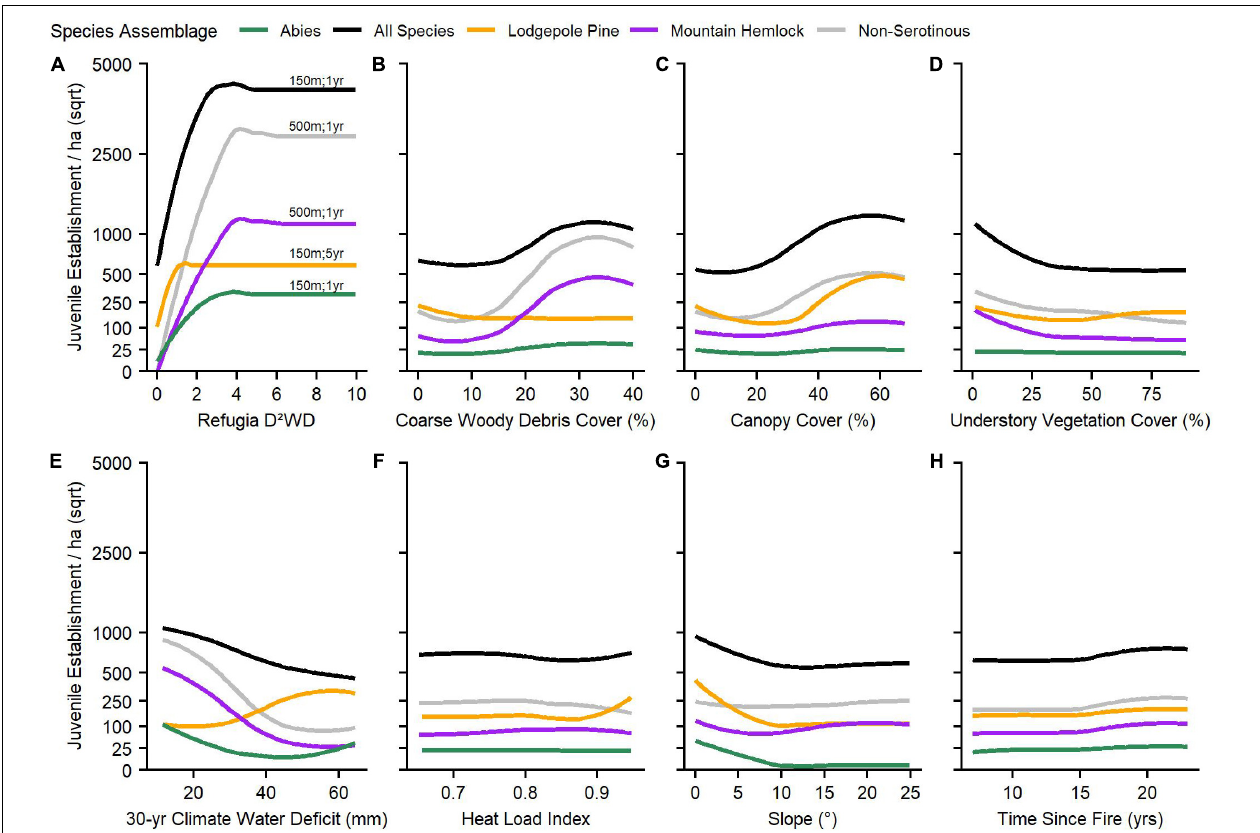
FIGURE 4 | Partial dependence plots illustrating the smoothed flexible relationship between post-fire conifer juvenile establishment responses and refugia, climate, and environmental variables, by species assemblage (A–H) . Each plot represents the fitted values of juvenile establishment response (y) due to the predictor variable (x), while keeping all other predictor variables fitted in models at their mean values. For the refugia D2WD variable, the best performing neighborhood radius and post-fire temporal snapshot associated with each species assemblage model is listed above each response curve (i.e., #m; #year). Refugia D2WD was the most important predictor of post-fire juvenile establishment responses across species assemblages ( Table 3 ) and thus exhibited the greatest relative influence on establishment responses (y). Y-axes are shown in a square-root